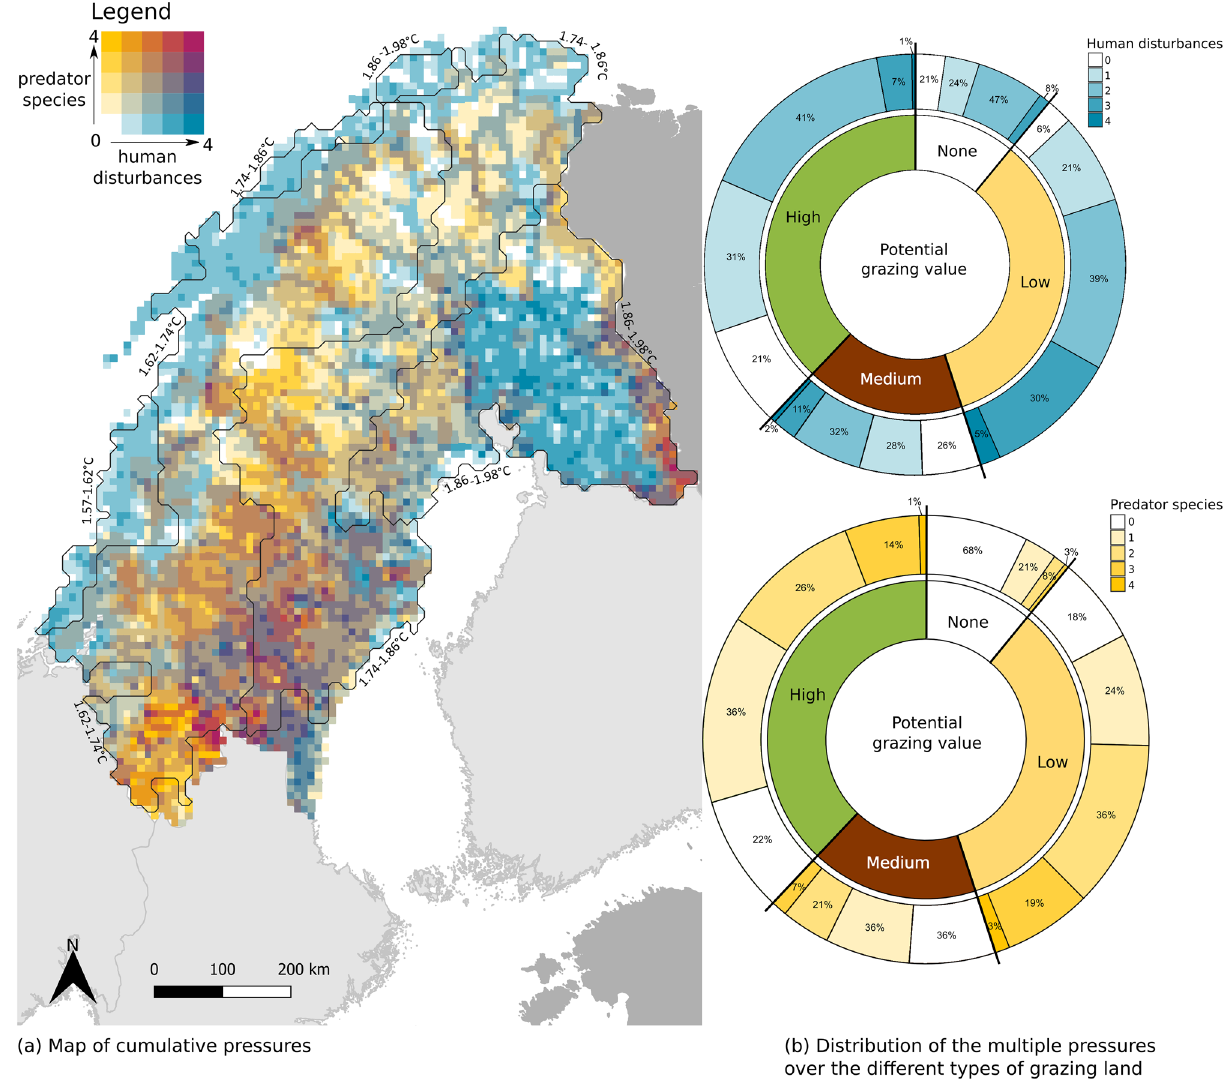
Figure 4. ( a ) Map showing the cumulative pressures affecting extensive domestic grazing over northern Fennoscandia. Temperature changes modelled for 1959 until 2018 are depicted with contour lines. Note that the bivariate colour legend ends at four land-uses co-occurring in one grid cell for visual purposes, but six grid cells contained five land-use pressures, as well as predator presence (five grid cells were located in central Sweden and one in Finland next to the Russian border). This map was created with QGIS version 3.4.7, accessed on www. qgis. org. The country borders were from Eurostat ©EuroGeographics. ( b ) Distribution of the multiple pressures (co-occurring land-uses in shades of blue and co-occurring predator species in shades of yellow) over the different types of grazing land. For each potential grazing value, the percentages show the extent (in number of grid cells) under cumulative pressures. Note that six grid cells contained five land-uses but were not included in this graph for visual